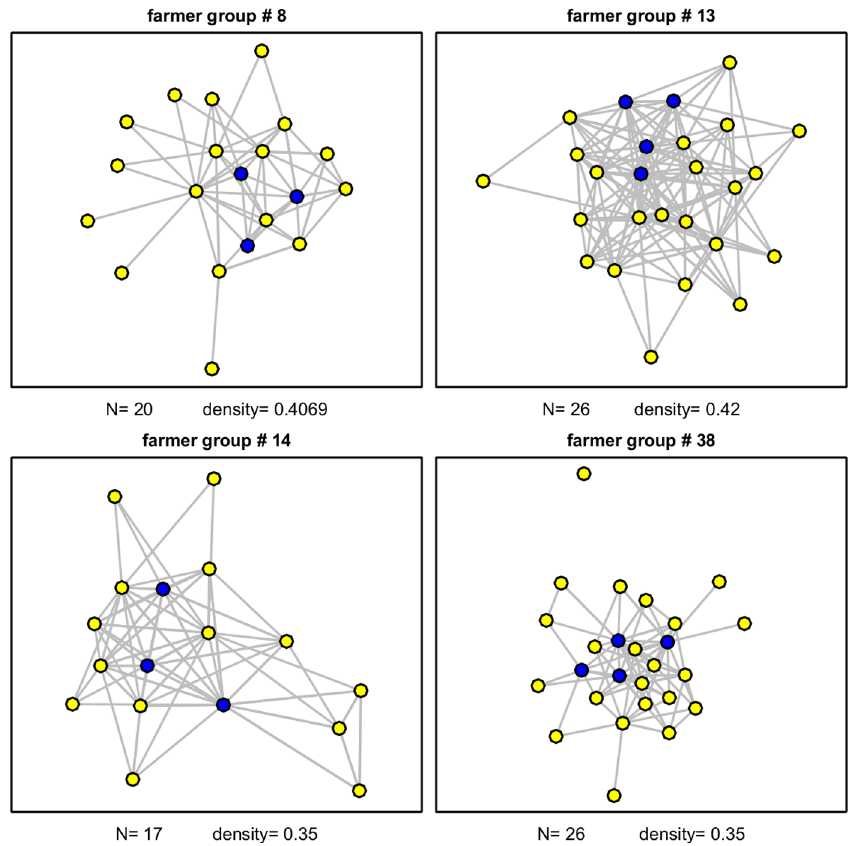
Figure 4. Relationship between formal and network position in the social structure. High-rank leaders (blue nodes) occupy network positions of greater centrality. The graphs show the structure of the communication network of four randomly selected farmer groups in our sample.